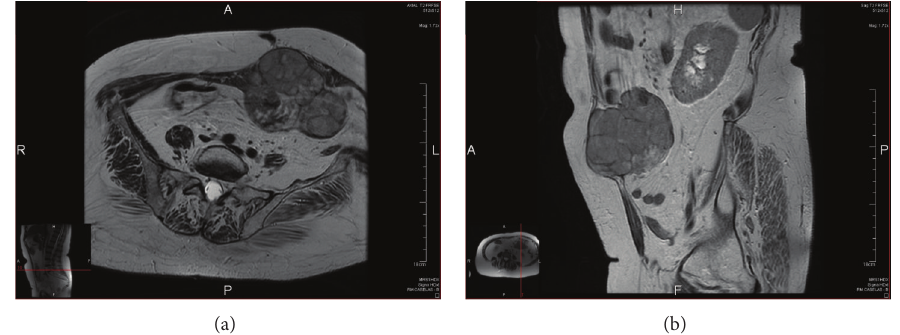
Figure 1: MRI demonstrates the tumour on the left side of the anterior abdominal wall protruding into the abdominal cavity. (a) Axial T2-weighted image and (b) sagittal T2-weighted image.